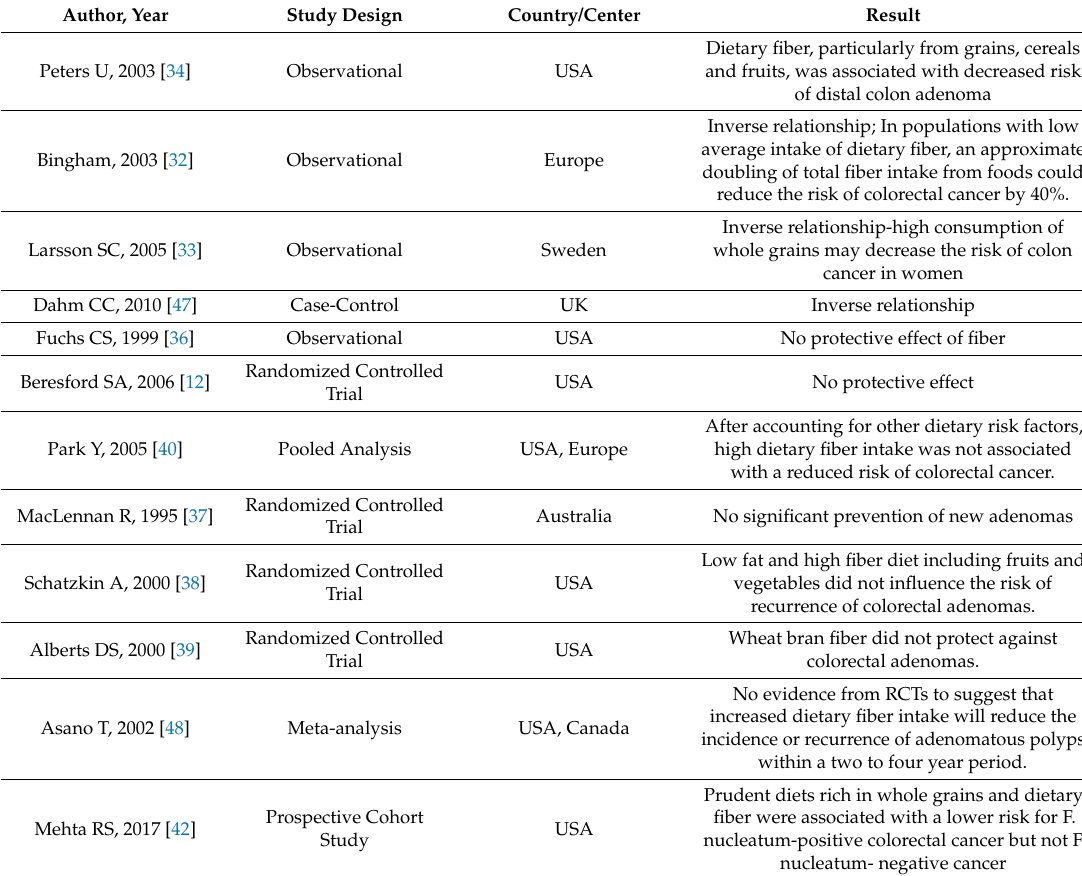
Table 5. Summary of major epidemiological studies examining the association of fiber intake with